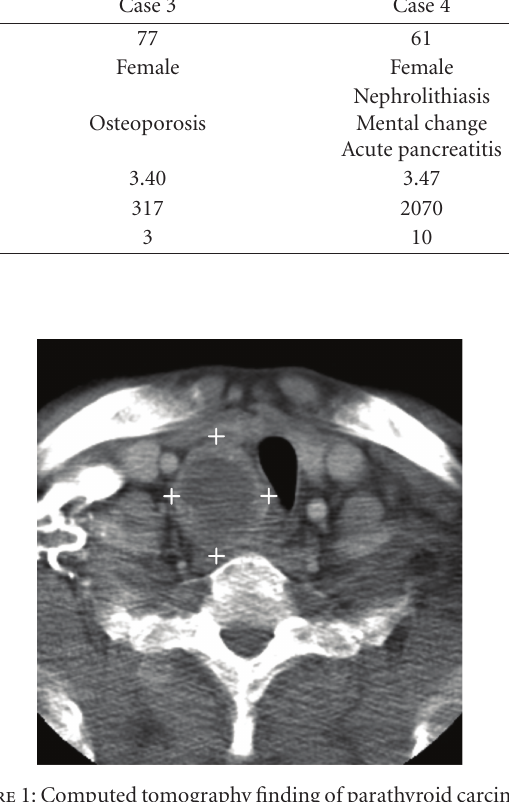
Figure 1: Computed tomography finding of parathyroid carcinoma (transverse)—a cystic tumor in the upper mediastinum, tracheal deviation.